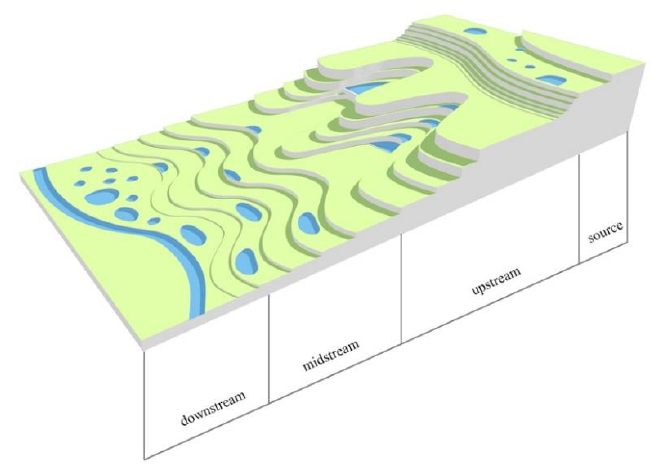
Figure 4. The landscape pattern in Huizhou.